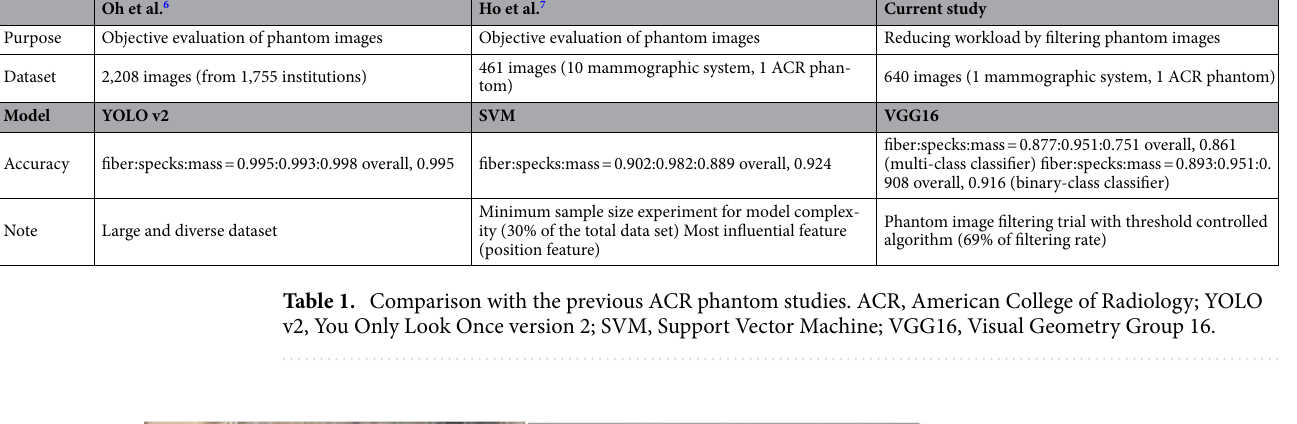
Oh et al. 6 Ho et al. 7